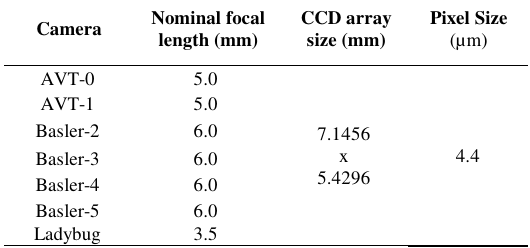
Figure 3. Configuration of the utilized photogrammetric mobile mapping system. Table 1. Characteristics of the utilized cameras.